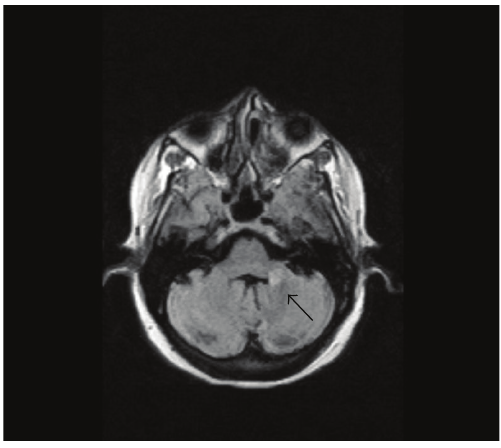
Figure 5: Axial T2 FLAIR image shows small hyperintense lesion in the left middle cerebellar